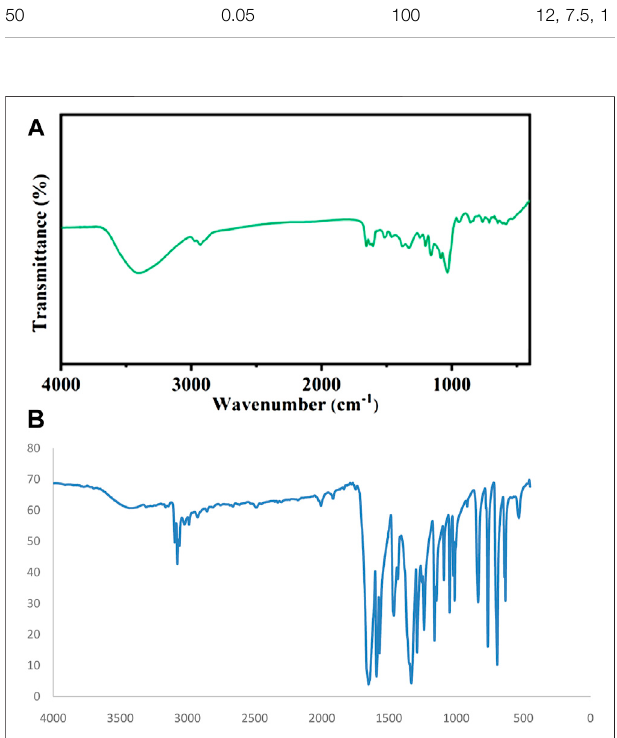
FIGURE 1 | FT-IR spectrum of (A) cyclodextrin (B) nano fi bers based on